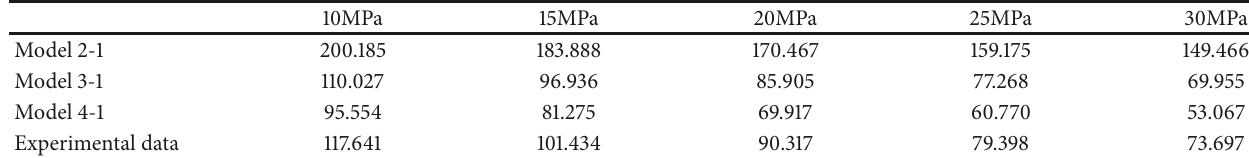
Table 2: Comparison of experimental and theoretical results of coal rock fracture conductivity.